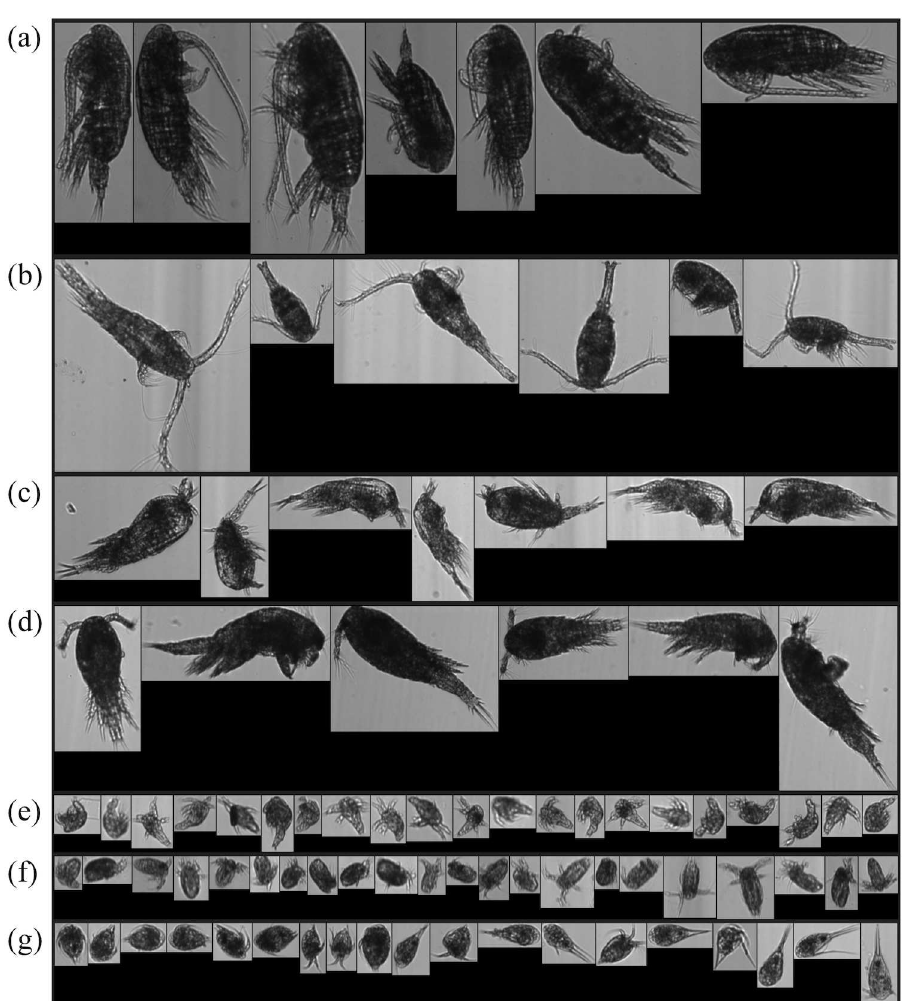
Fig 3. Examples of FlowCAM images of the 7 dominant copepod morphotypes. Examples from FlowCAM image libraries that were built prior to the semi-automatic classification for the 7 dominant copepod morphotypes: (a) calanoidcopepodite, (b) oithonid (cyclopoid) copepodite, (c) corycaeid(poecilostomatoid) copepodite, (d) oncaeid(poecilostomatoid) copepodite, (e) calanoidnauplius, (f) cyclopoidnauplius,and (g) harpacticoid